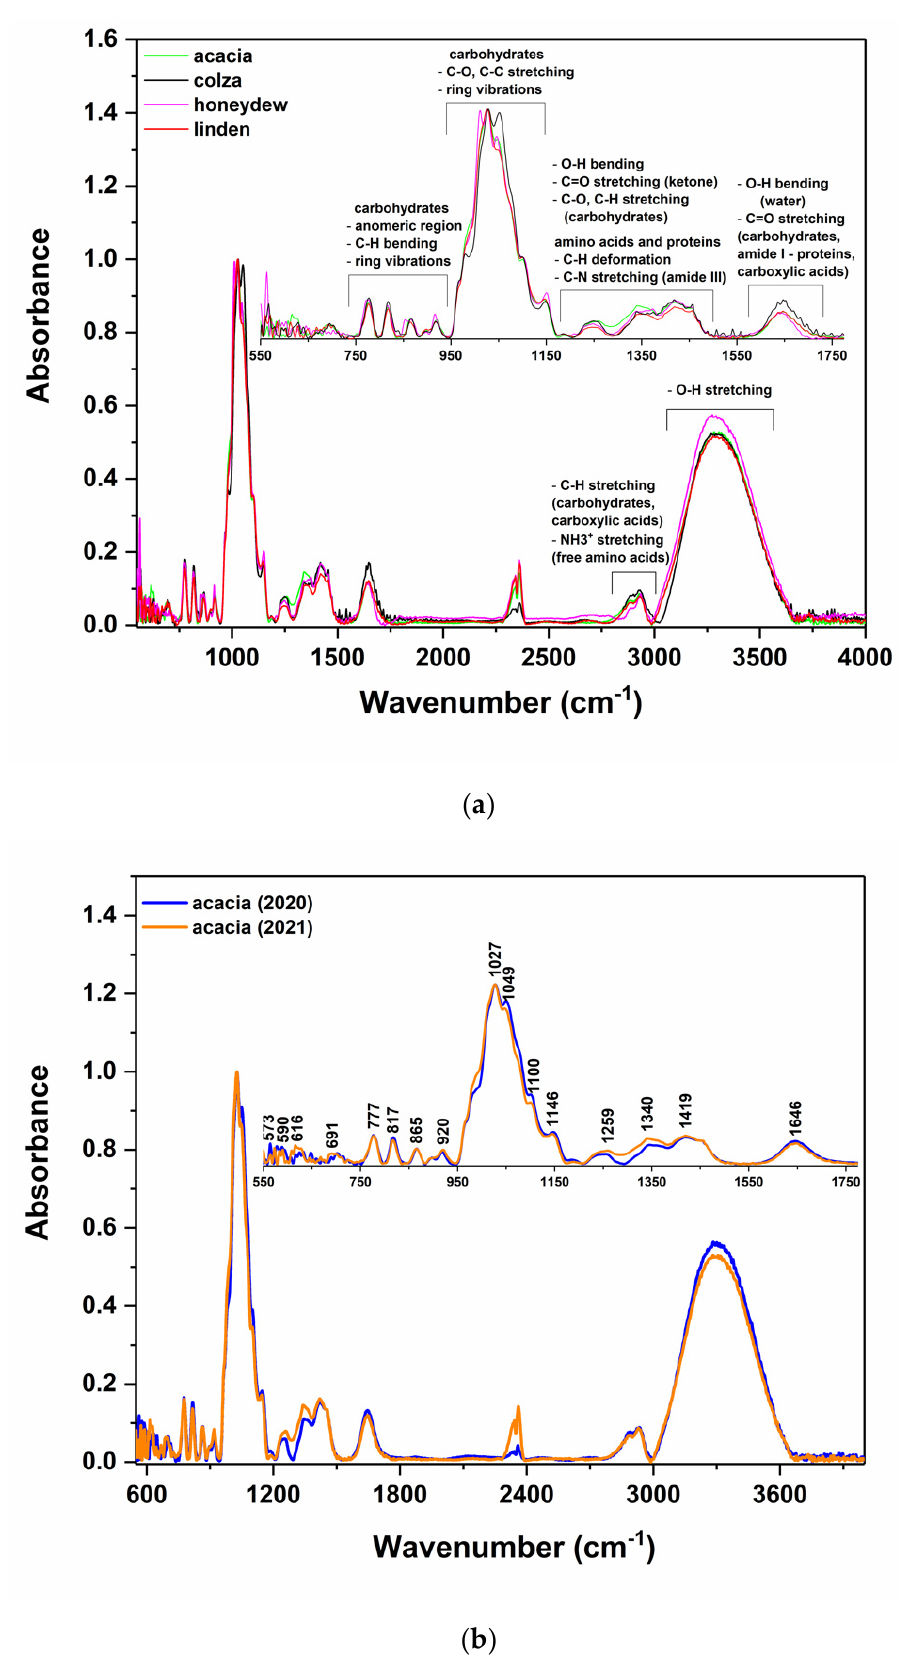
Figure 1. ATR-FTIR experimental spectra of ( a ) honey varieties, ( b ) different harvesting years of acacia honey.